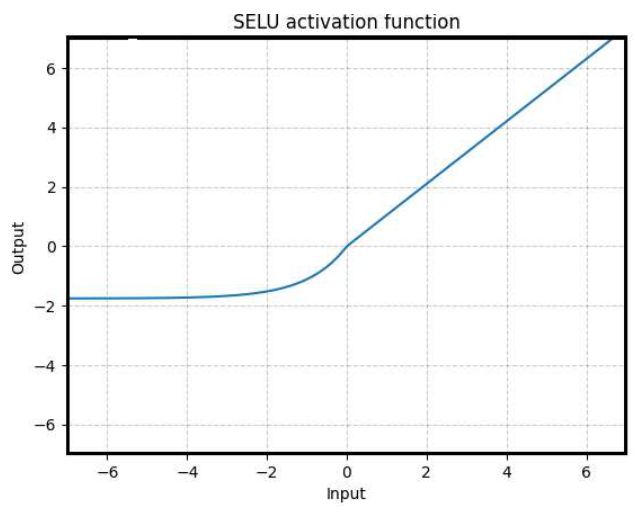
Figure 5. SELU activation function.